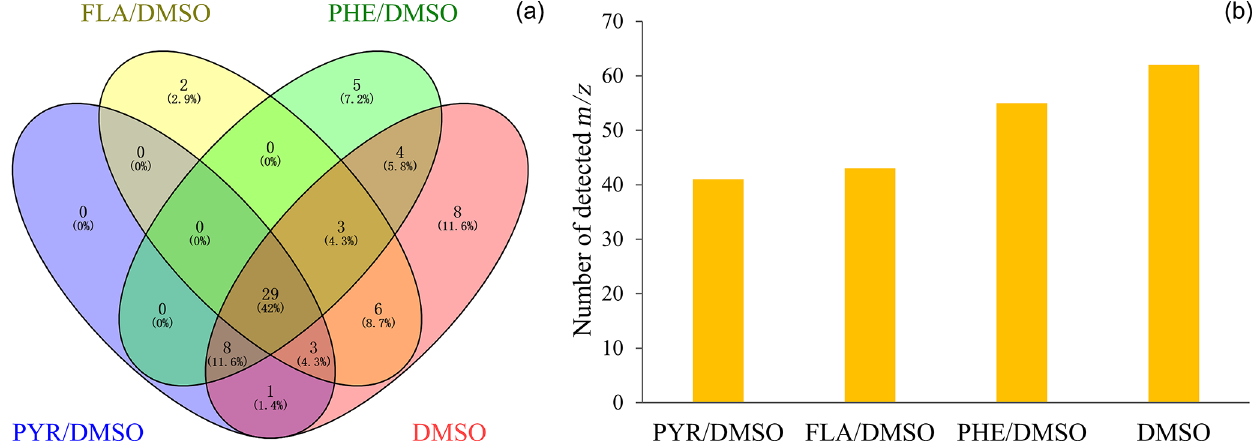
Figure 1. Venn diagram of the detected m/z signals in the gas phase for the heterogeneous reaction of SO 2 with DMSO and PAHs/DMSO under light irradiation (300nm <λ< 700nm) (a) . The total number of identified m/z signals between the heterogeneous reactions of SO 2 with DMSO and PAHs/DMSO, under light irradiation (b) .